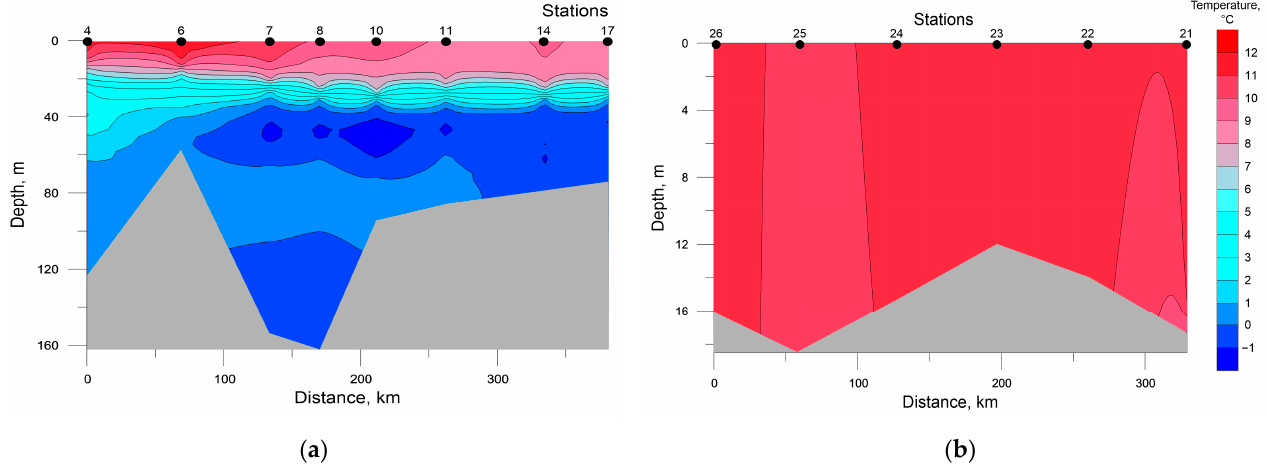
Figure 2. Distribution of seawater temperature at the investigated transects in the southwestern Kara Sea ( a ) and the southeastern Barents Sea ( b ).